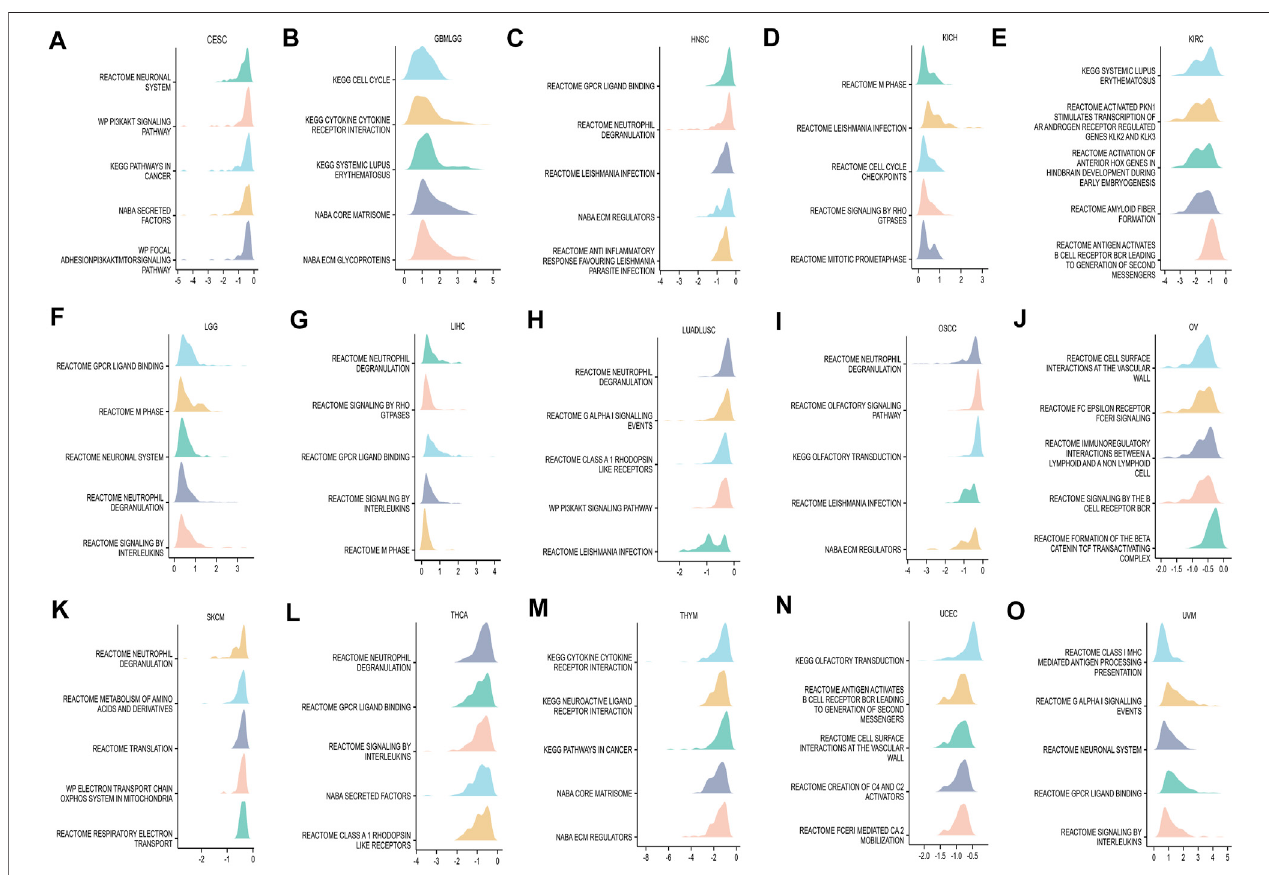
FIGURE 6 | GSEA of BCL7B in pan-cancer. (A – O) Top fi ve GSEA terms in indicated tumor types.